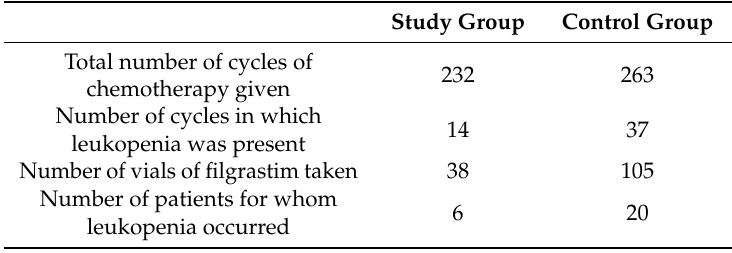
Table 2. Descriptive statistics for patients in study and control group.